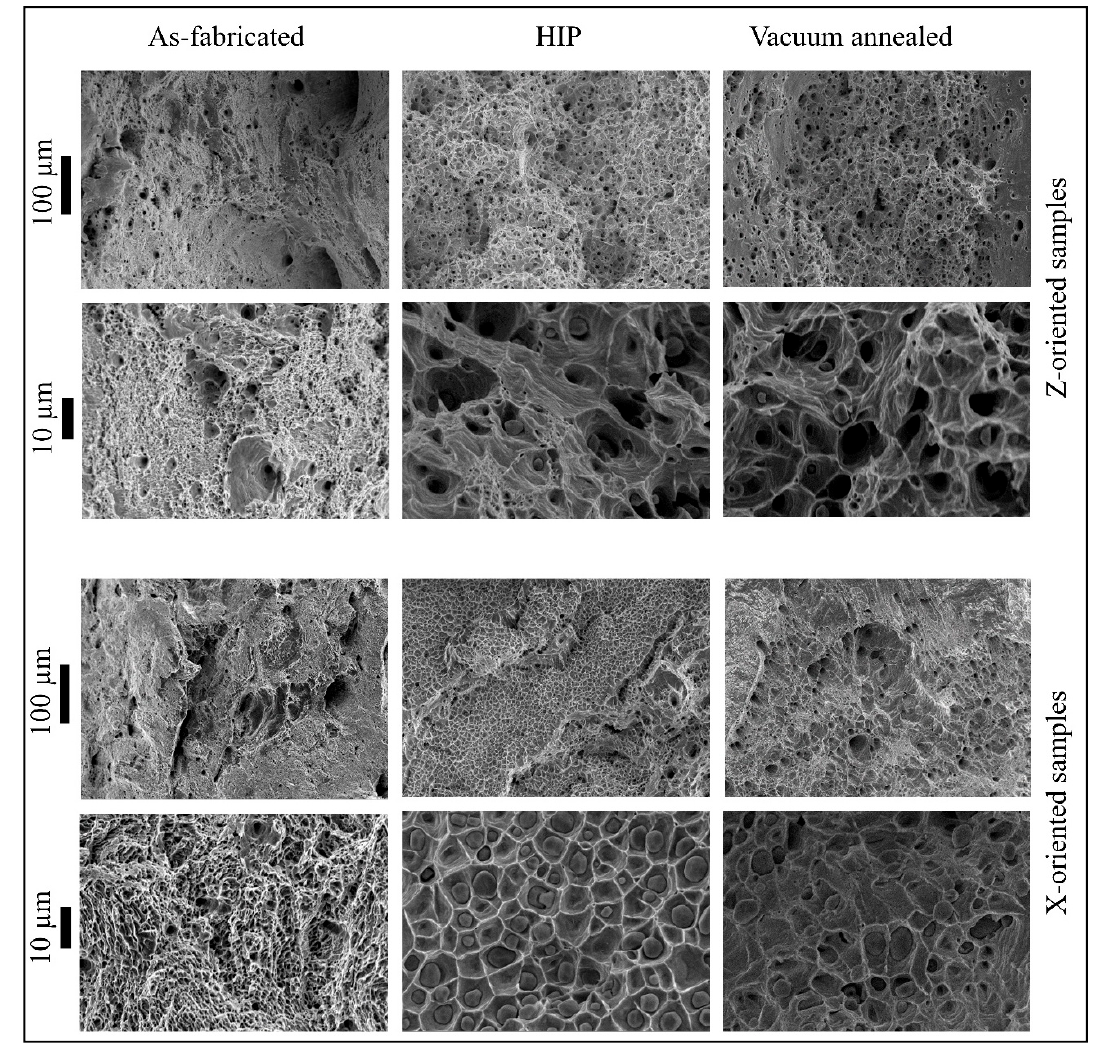
Figure 8. Fractographs of tensile specimens; top two rows: Z-oriented specimens (as-fabricated, HIP, and vacuum annealed); bottom two rows: X-oriented specimens (as-fabricated, HIP, and vacuum annealed); each scale bar is associated with the respective row.